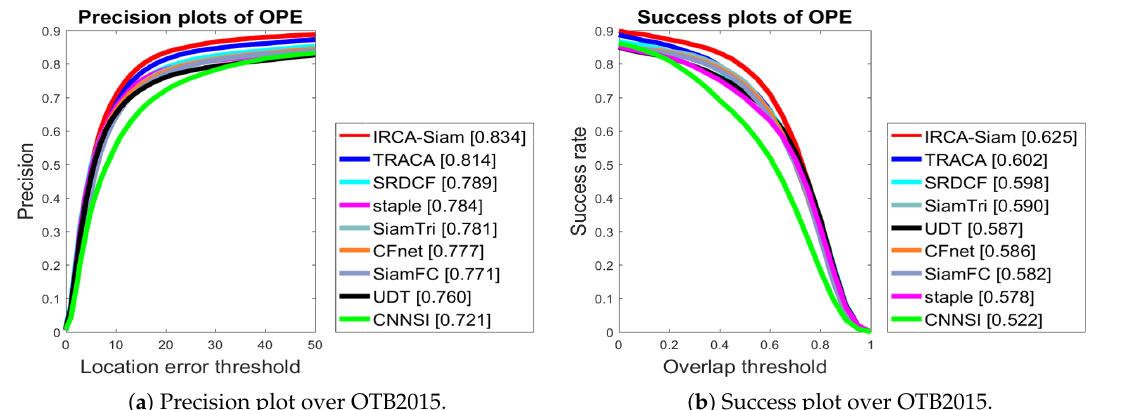
( a ) Precision plot over OTB2015. ( b ) Success plot over OTB2015. Figure 3. Performance comparison over